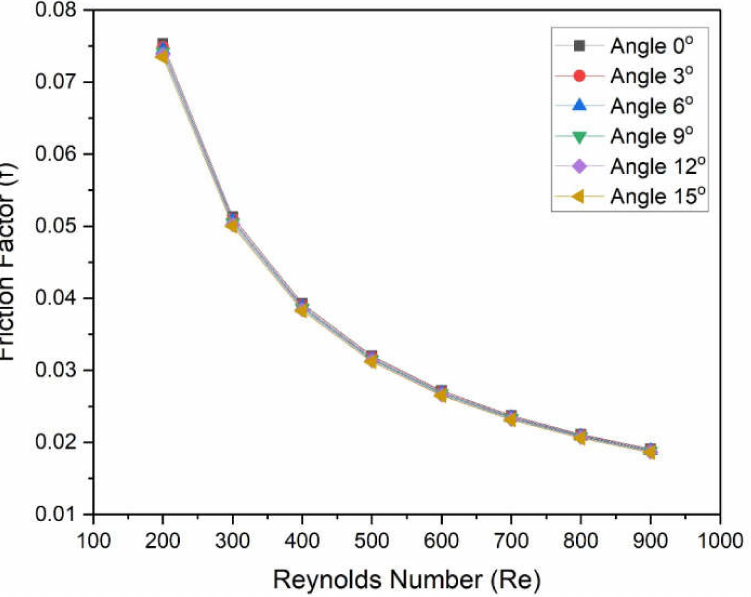
Figure 11. Variation in Friction factor of microchannel heat sinks with Reynolds numbers for different